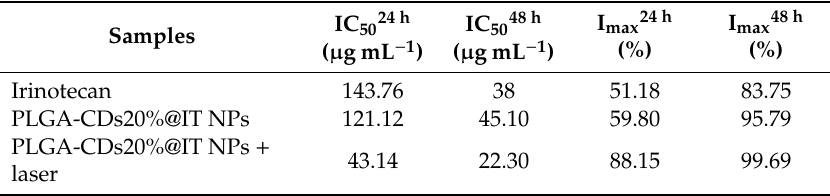
Table 2. Half minimal inhibitory concentration (IC 50 ) and maximal inhibition (I max ) of PLGA-CDs20%@IT NPs compared to the free drug (IT) after 24 and 48 h of incubation on 2-D culture of